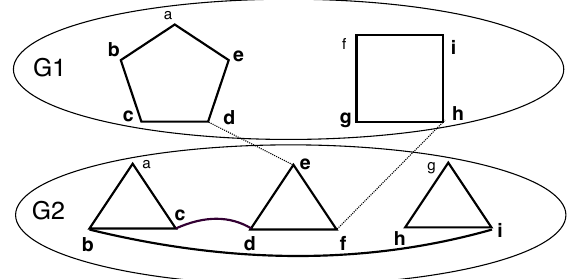
Figure 4. MCV: The vertices of a minimum connected vertex cover are { b , c , d , e , g , h , i } from G 1 and { b , c , d , e , f , h , i } from G 2 . The cardinality of any MCV of G is 14. The vertices of MCV are shown in larger bold